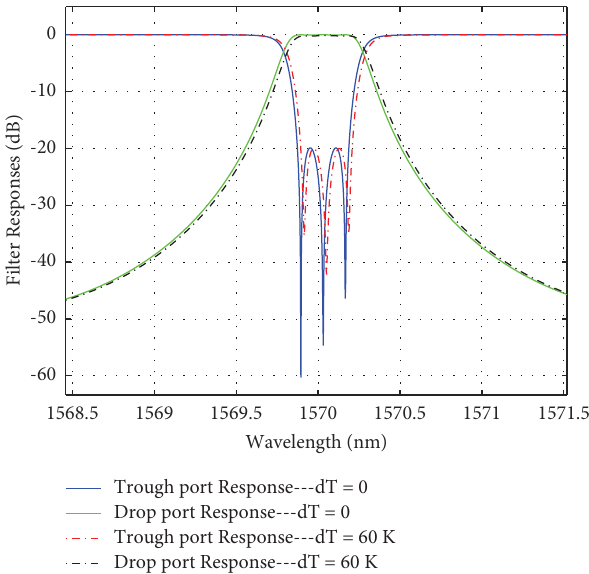
Figure 14: Filter response afected by a heat source from the bottom of the substrate of the flter (thermo-optic efects) and thermal deformation (stress-optic